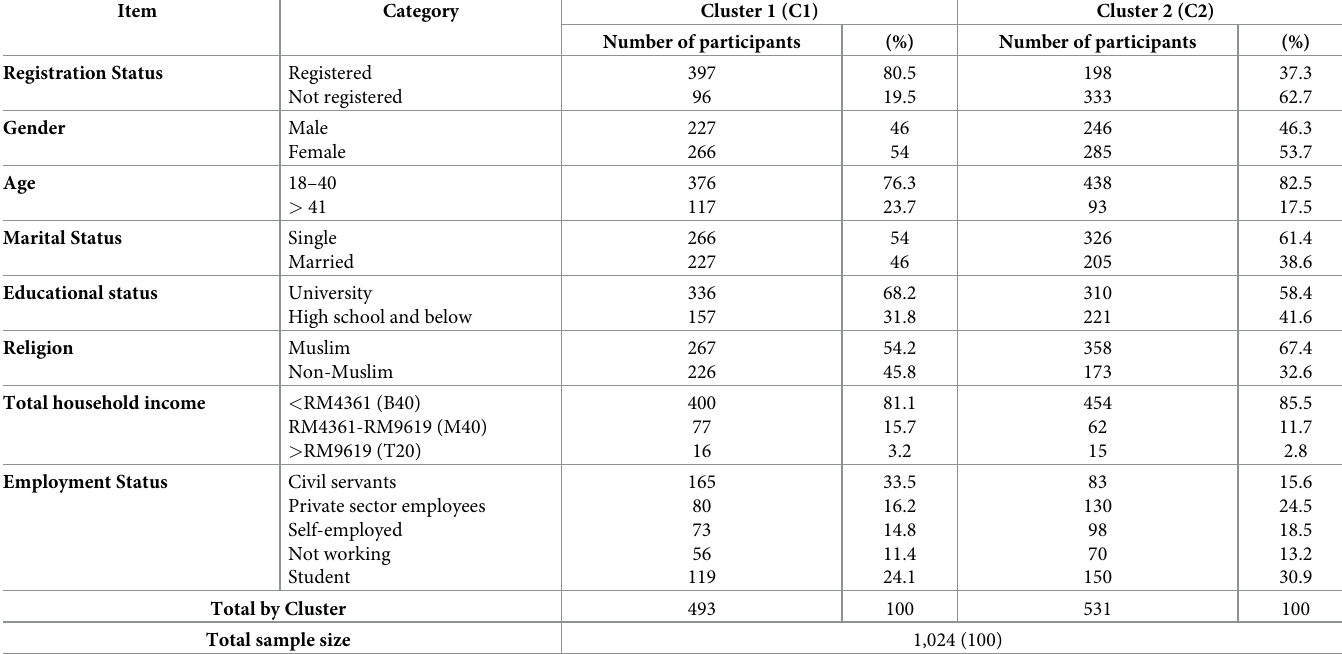
Table 6. Demographic profile of respondents based on